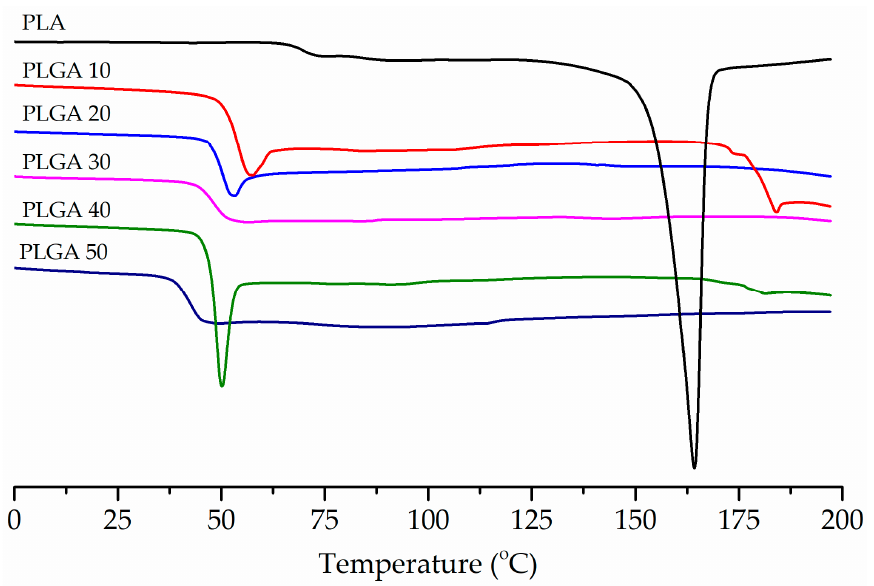
Figure 2. Differential scanning calorimetry (DSC) thermograms of polylactide (PLA) and PLGA, showing the thermal transition.